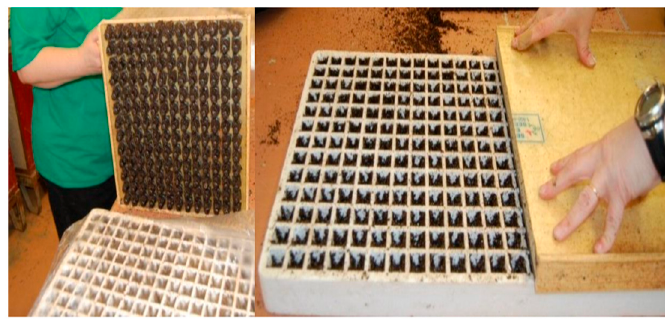
Figure 3. Conventionally-built plate dibbler.